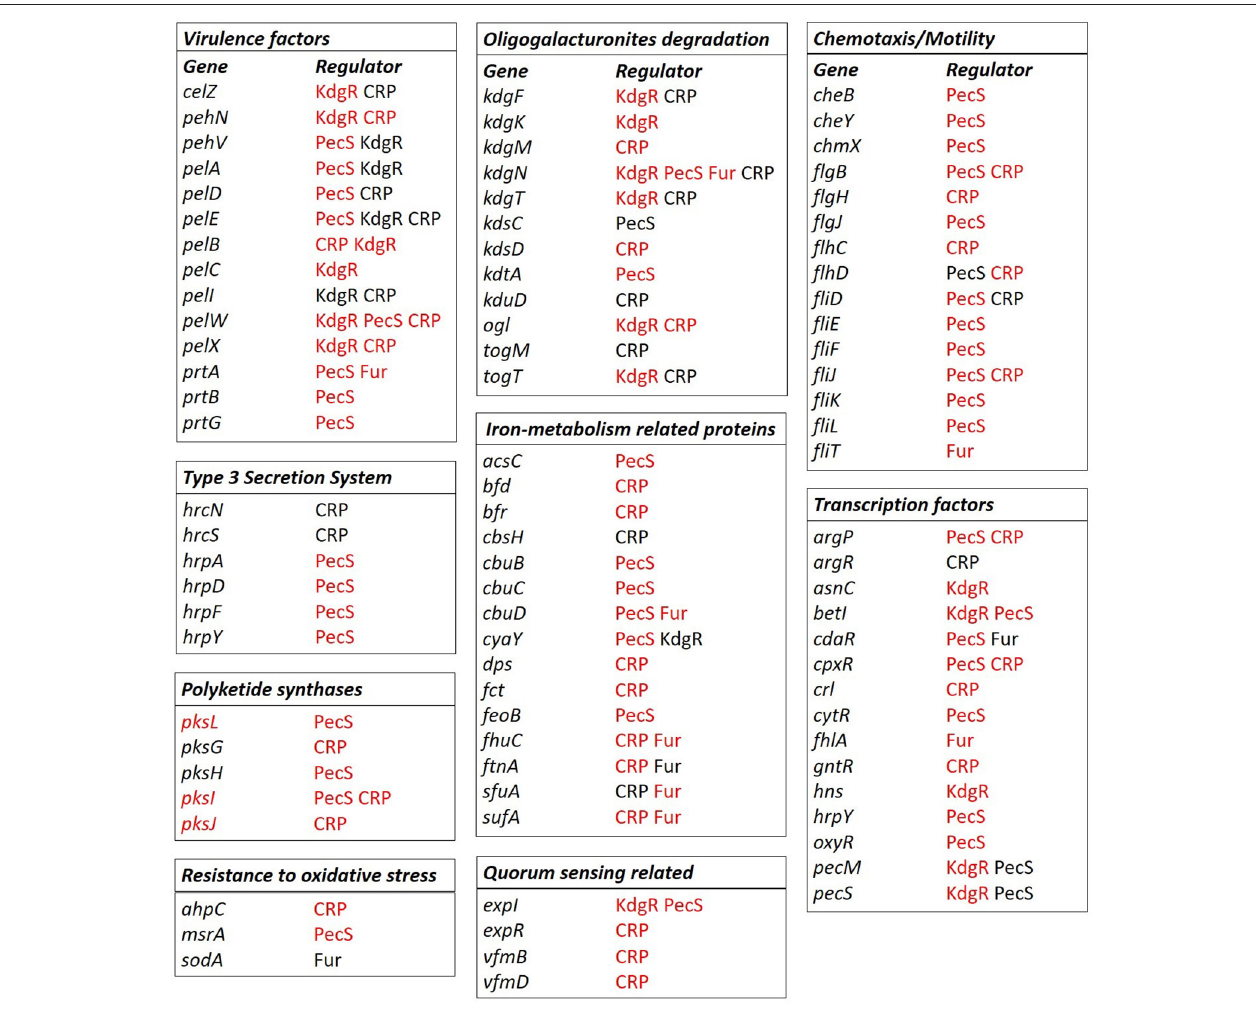
FIGURE 8 | Selected regulons of D. solani based on binding sites predictions. Predictions of the CRP, Fur, KdgR, and PecS (TFs) binding sites were conducted with the use of MAST version 4.10.1. (Bailey and Elkan, 1994) and Bio.motifs package from Biopython library (version 1.62b) (Cock et al., 2009) for the virulence factors: proteins involved in pectin and oligogalacturonide degradation, chemotaxis, and motility, iron metabolism, polyketide synthesis, resistance to oxidative stress, transcription factors, quorum sensing-related proteins and T3SS components. Gene names are marked in black when the genes belong to the core genome and in red when the genes belong to the accessory genome fractions. The TFs name is given in black to indicate the core regulon, and in red to indicate the accessory